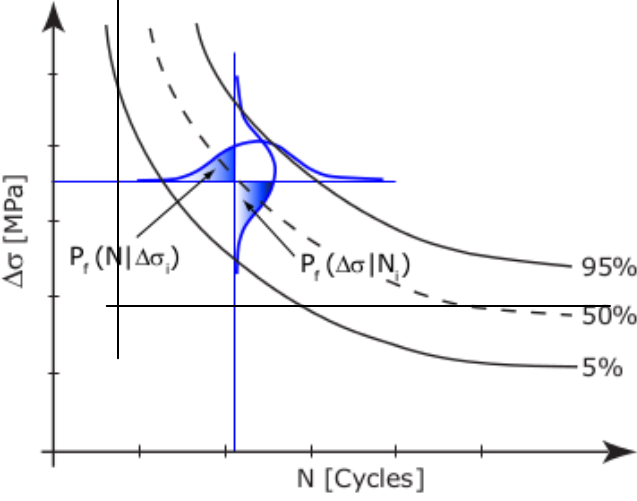
Figure 4: S-N field according to [6] illustrating the compatibility condition.